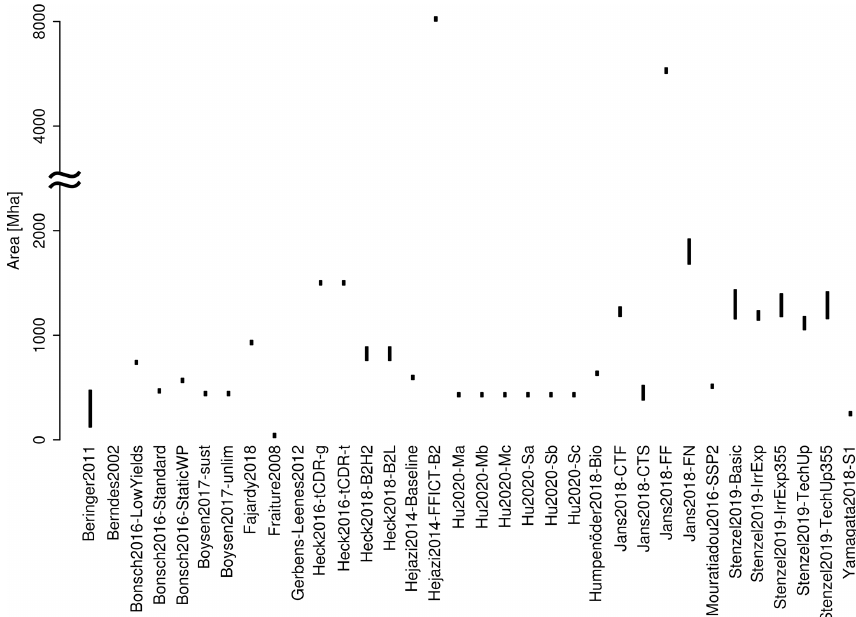
Figure A1. Overview of reported total global area of bioenergy plantations.